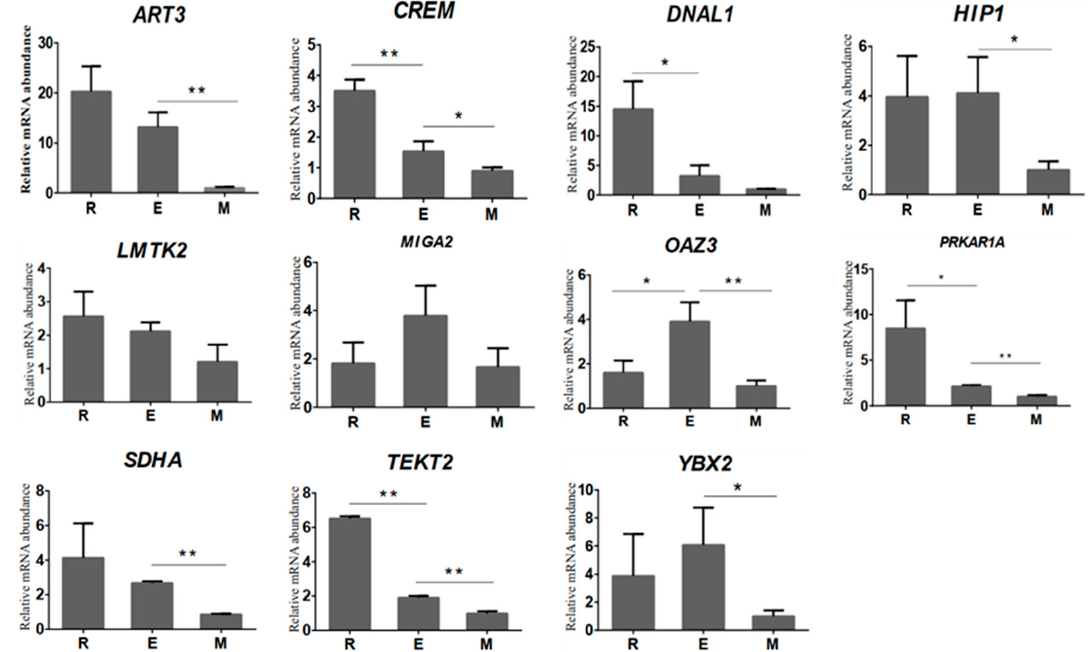
Figure 3. RT-qPCR analysis results of the relative mRNA abundance of 11 genes in bovine round spermatids, elongated spermatids, and epididymal sperm. The horizontal axis represents the type of sample, and the vertical axis represents the relative mRNA abundance normalised to that of β -actin. The relative mRNA abundance of 11 genes was represented as the mean, with error bars indicating standard error of the mean (mean ± SEM). Student’s t -test was used to assess the statistical significance of experimental data (* p < 0.05, ** p < 0.01).